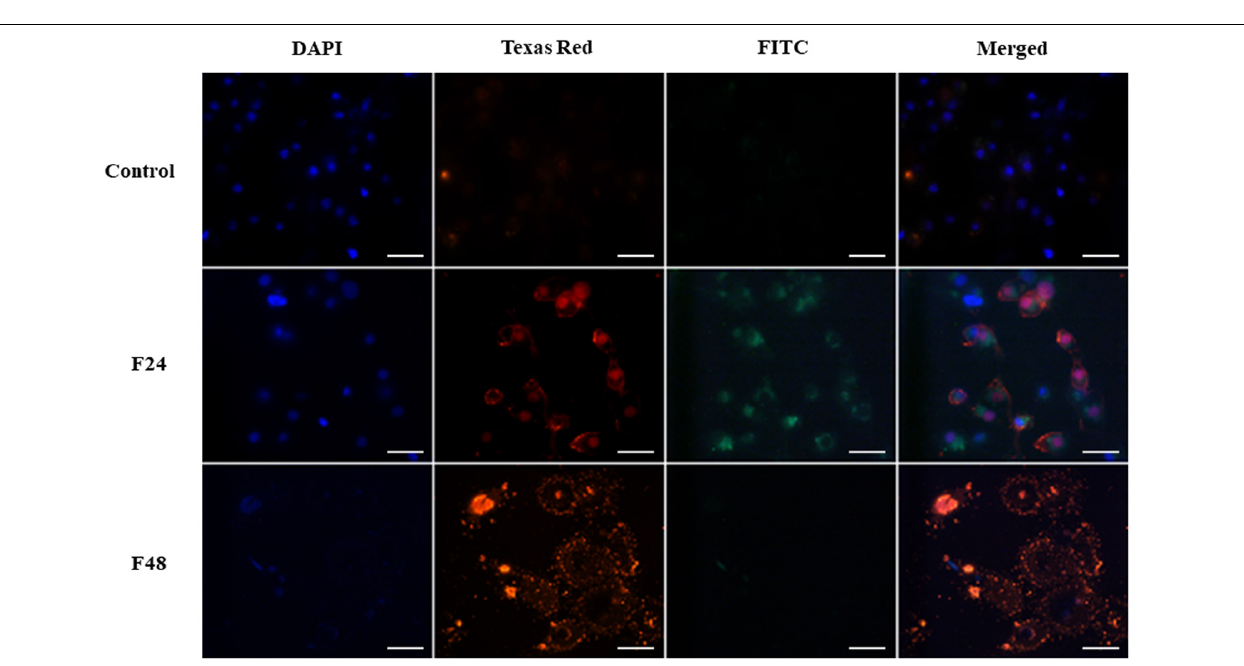
FIGURE 2 | Fungal infection of G. mellonella larvae induced apoptosis and necrosis of hemocytes. The analysis was performed using the GFP CERTIFIED Apoptosis/Necrosis Detection Kit (Enzo Life Sciences). Texas Red filter, necrosis/late apoptosis detected by 7-AAD; FITC filter, apoptosis detected by Annexin V conjugated with GFP; DAPI filter, cell nuclei. Control (negative control), non-infected, healthy larvae; F24, larvae sampled immediately after 24-h exposure to C. coronatus sporulating colonies; F48, larvae sampled 24 h after 24-h exposure; scale bar 25 µ m.